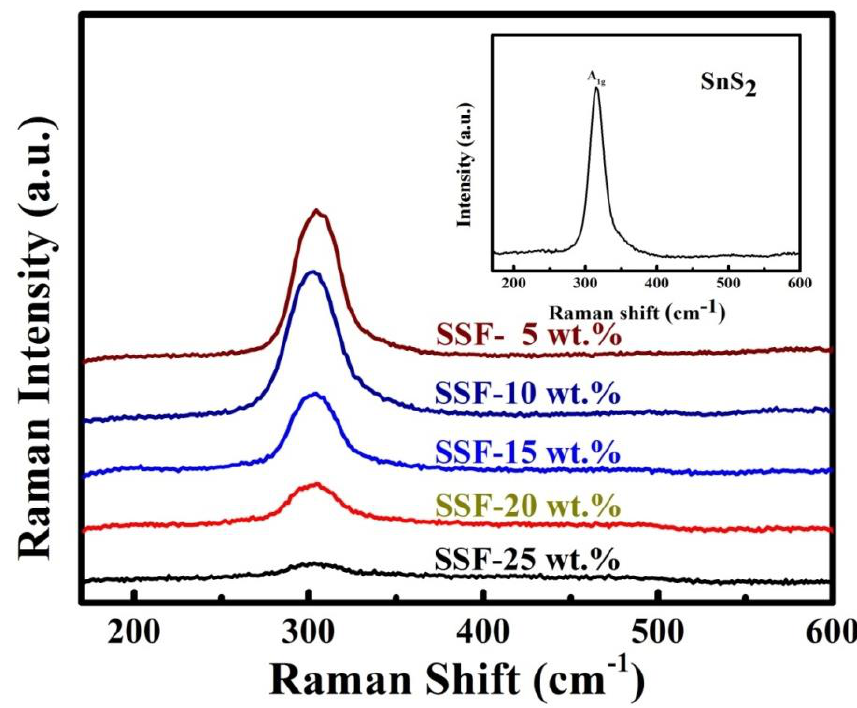
Figure 8. Raman spectra of SnS 2 -SiO 2 @ α -Fe 2 O 3 nanocomposites with various concentrations (SSF-5, 10, 15, 20, and 25 wt %); inset shows the Raman spectra of flower-like SnS 2 .